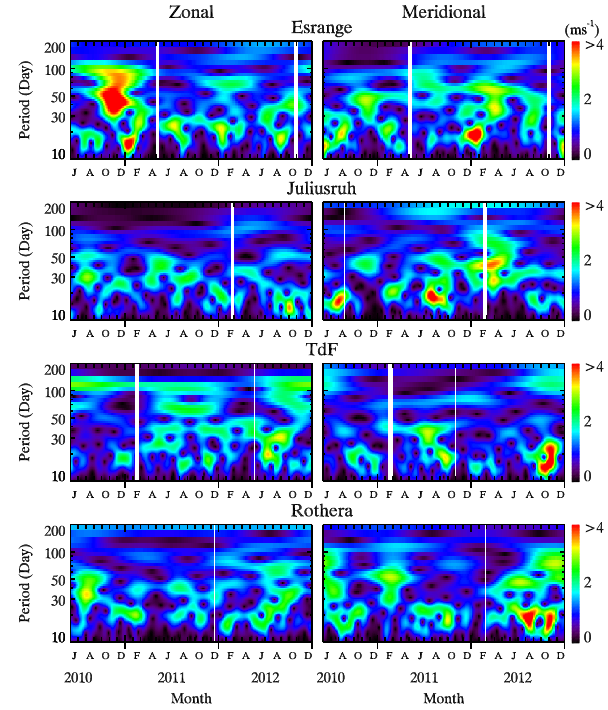
Figure 8. S-transform amplitudes of 5DW amplitudes at 90km in the zonal (left) and meridional (right) winds over Esrange, Julius- ruh, Tierra del Fuego, and Rothera from top to